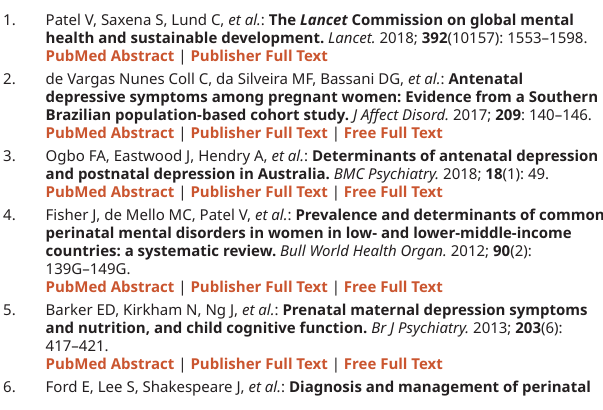
Figshare: Maternal Depression experiences FDG transcription,